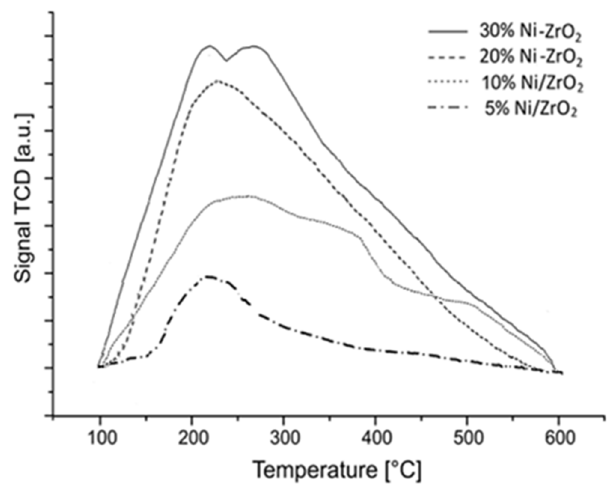
Figure 17. TPD-NH 3 profile of Ni/ZrO 2 catalysts reduced in hydrogen for 1h at 500 °C.